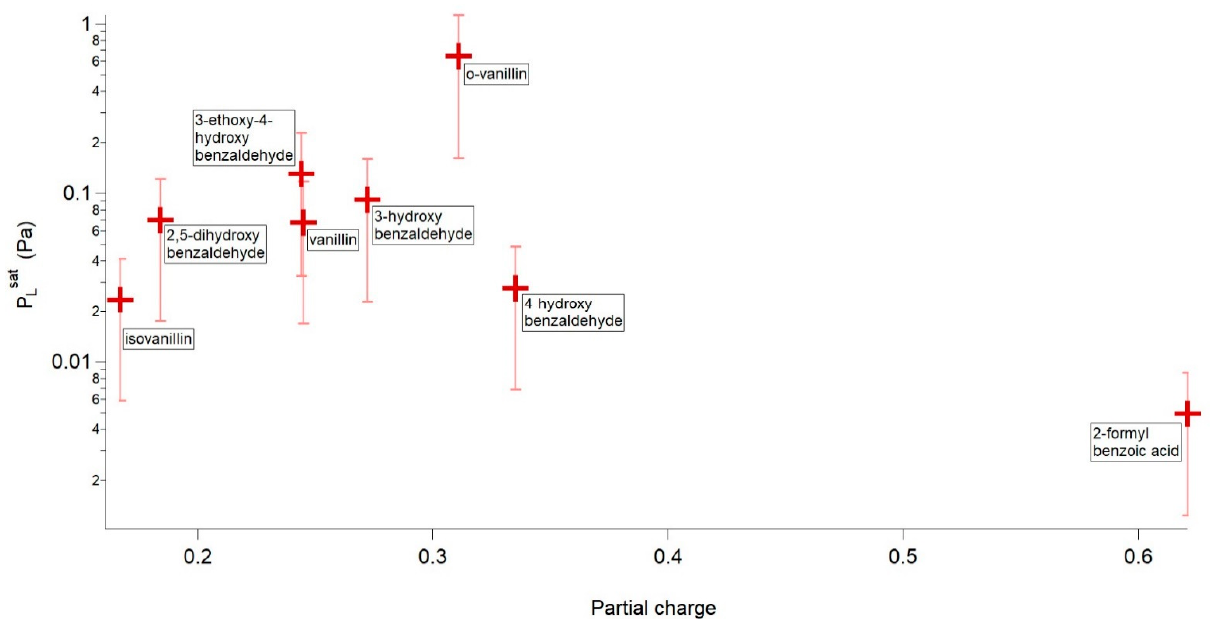
Figure 2. P sat vs. partial charge of the phenolic/carboxylic carbon for the compounds capable of H-bonding. Error bars are ± 75%.